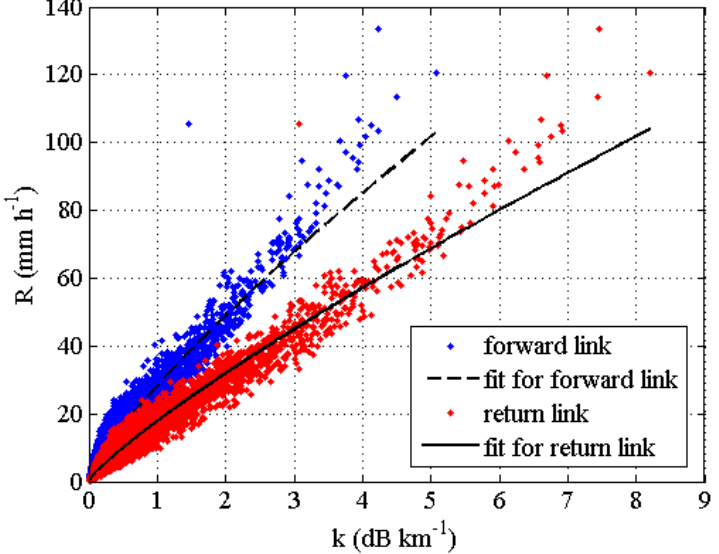
Figure 8. Scatterplot between rain rate R (in mm/h) and specific attenuation k (in dB/km) for the forward link (blue dots) and for the return link (red dots), both in the Ku-band. The two black lines represent the nonlinear regression of the data.